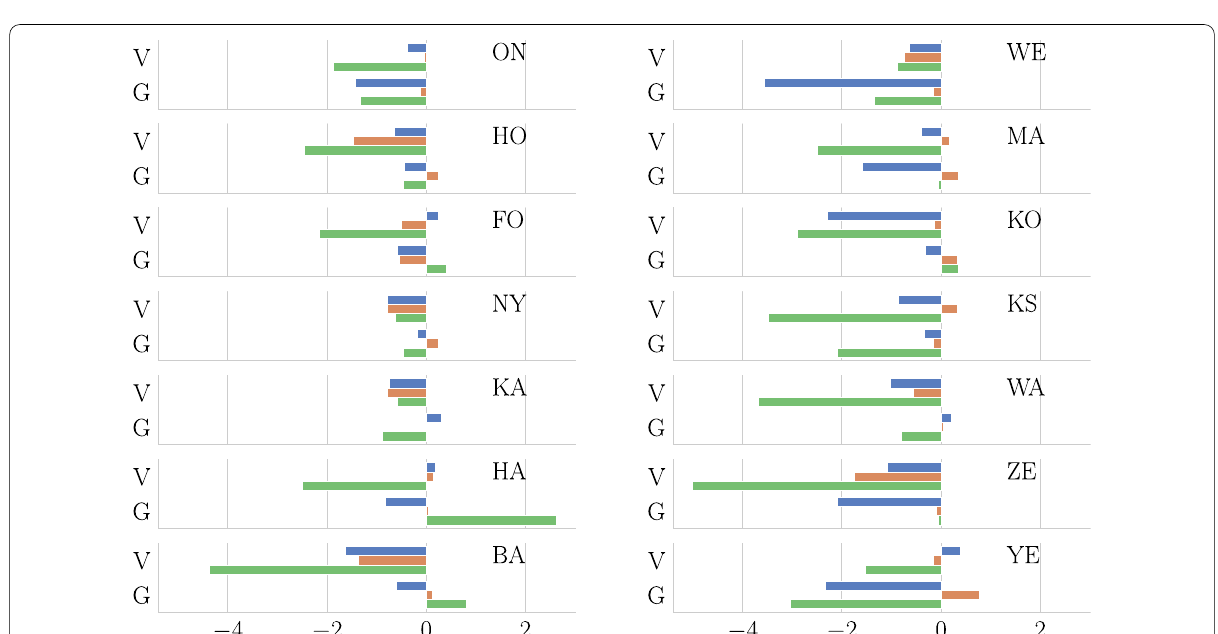
Fig. 7 Absolute change in repeatabilities (WRMS in mm) per station for the two co‑located networks between sol‑V and sol‑VG as well as sol‑G and sol‑VG. Negative change means that the combined solution lowers the repeatability, i.e., improvement. The components evaluated are north (blue), east (orange) and up (green) of the local topocentric